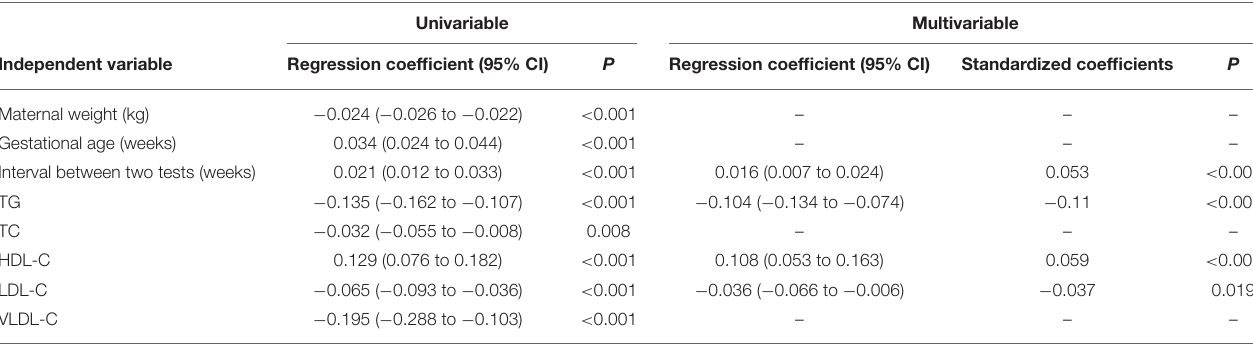
TABLE 2 | Regression analysis of factors from maternal characteristics and lipid metabolism for predicting √ fetal fraction in 4,514 pregnancies with male fetuses.